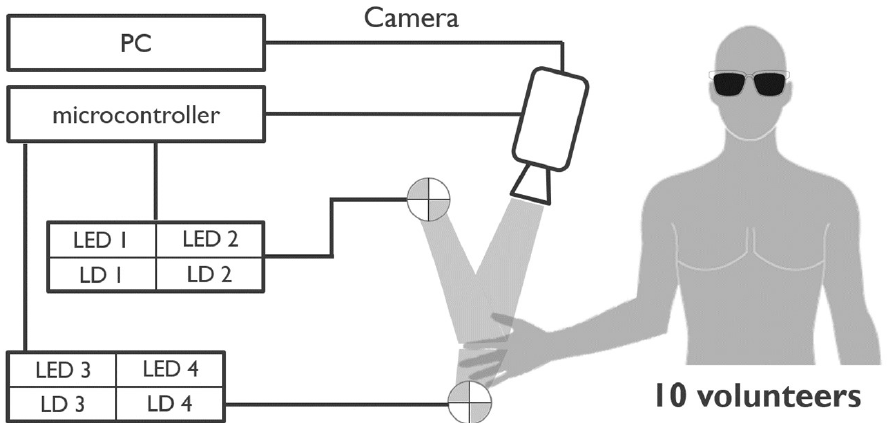
Figure 1. Measurement setup diagram.